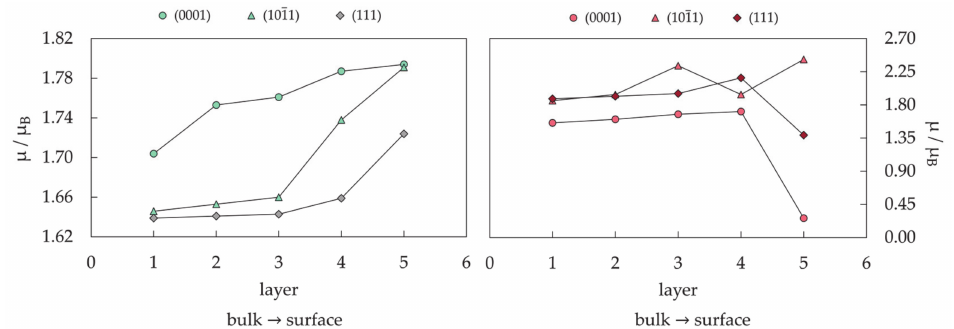
Figure 7. Magnetic moment per Co atom, µ , as a function of the atomic layer within the extended (cid:0) (cid:1) slab models of hcp ( 0001 ) , hcp 1011 , and fcc ( 111 ) surfaces of metallic cobalt— left : bare surfaces, right : oxidised surfaces. Layers are numbered going from bulk to the surface, 1 being the bulk-like inside layer and 5 being the top-most surface